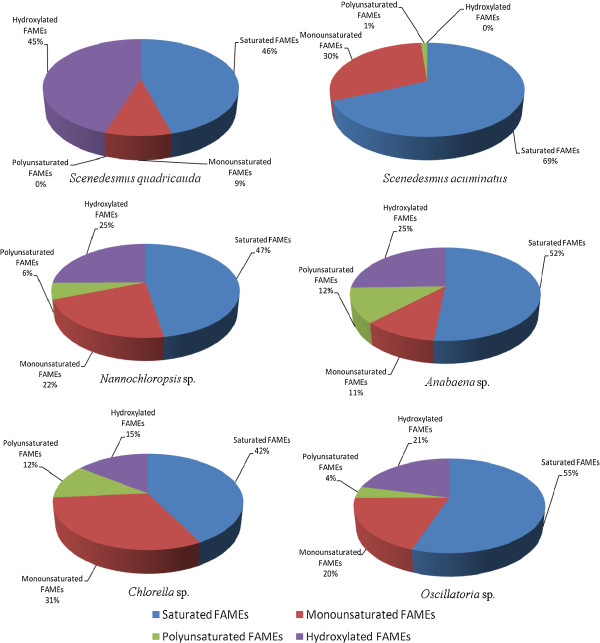
Distribution of FAMEs among various microagal strains.